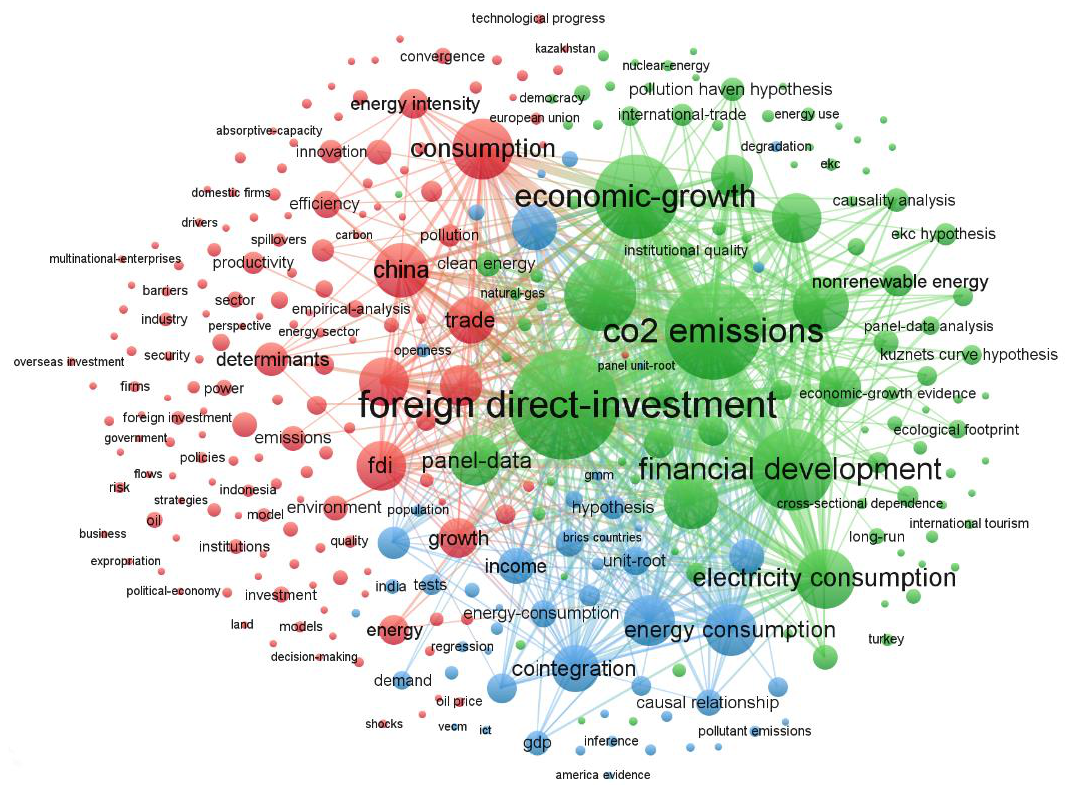
Figure 6. The keyword co-occurrence frequency colorful map (by VOSviewer).